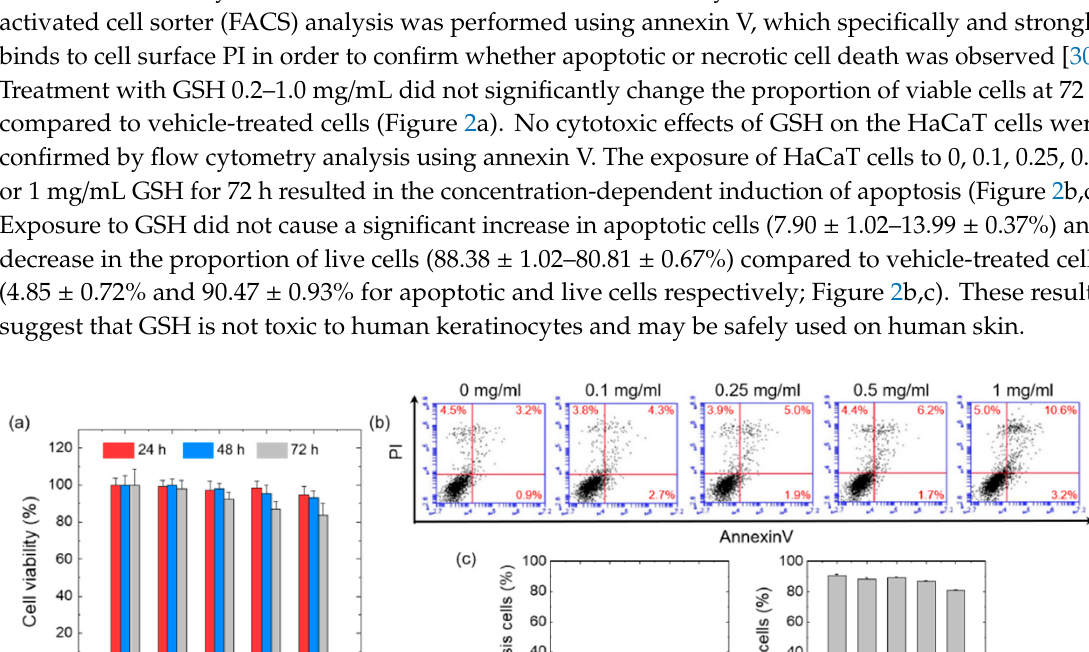
Figure 1. ( a ) Scoring analysis for odor test of reduced glutathione (GSH) and GSH-biopolymer formulations. Each volunteer ( n = 10) was asked to indicate the perceived mixed solution odor intensity using the following 5-point scale: 1: no odor, 2: recognizable odor, 3: easily noticeable odor, 4: strong odor, and 5: intense odor. ( b ) Gas chromatography (GC) analysis of released H 2 S from GSH and GSH-hyaluronic acid (HA) formulations by GC-flame photometric detector.